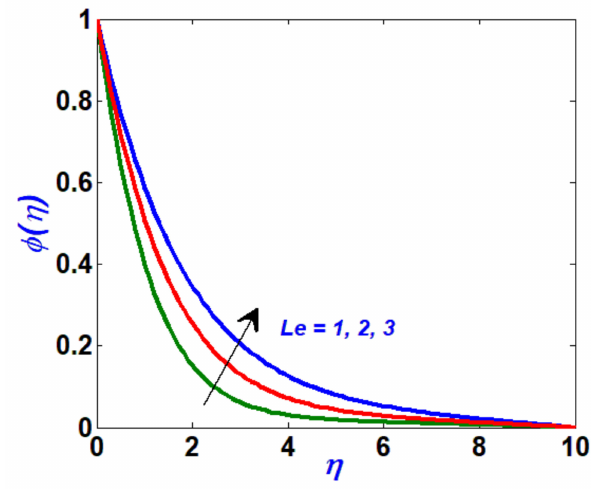
Figure 14. Concentration profile with variation in Le .